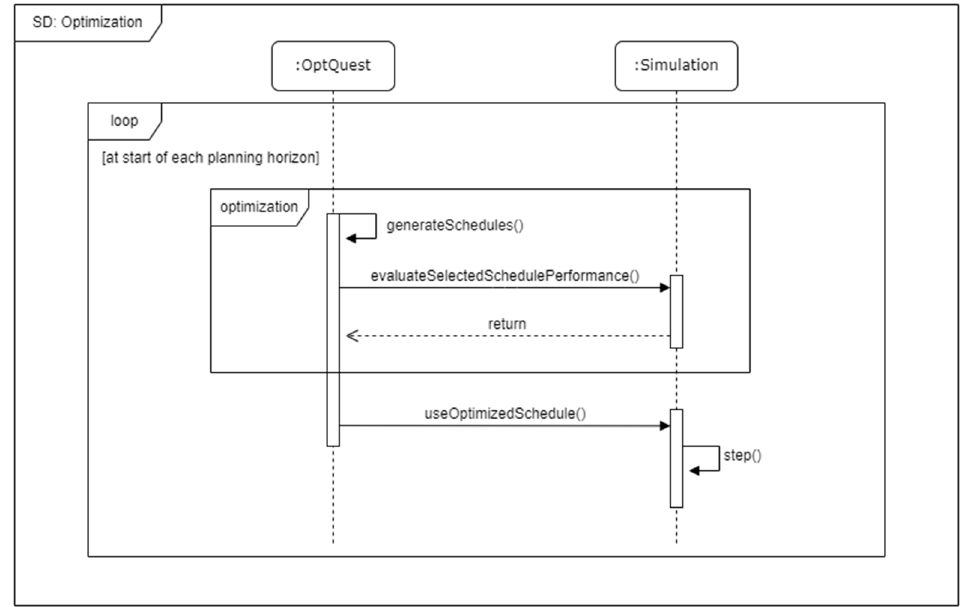
Figure 6. Sequence diagram showing the multi-objective optimization-simulation interaction.